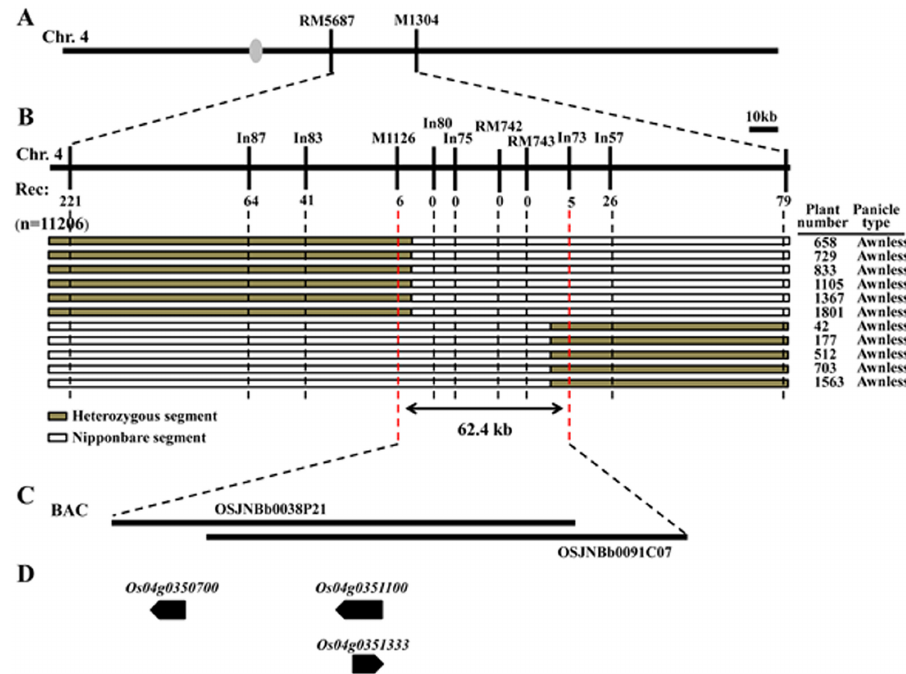
Fig 4. Fine mapping and gene prediction of Awn4-2 . (A) Awn4-2 was located between markers RM5687 and M1304 on rice chromosome 4L. Numbers of recombinants are shown below the position of the 11 markers. Chromosomal constitution of seven recombinants (plant numbers 658, 729, 833, 1105, 1367, 1801, 42, 177, 512, 703 and 1563) are shown with their panicle type. Grey and white bars represent chromosomal segment of heterozygous and Nipponbare, respectively. (B) Awn4-2 was fine mapped between markers M1126 and In73. (C) The Nipponbare genomic BACs (OSJNBb0038P21 and OSJNBb0091C07) in this region. (D) Gene prediction according to RAP-DB. The gray ellipse in (A) represents the centromere.